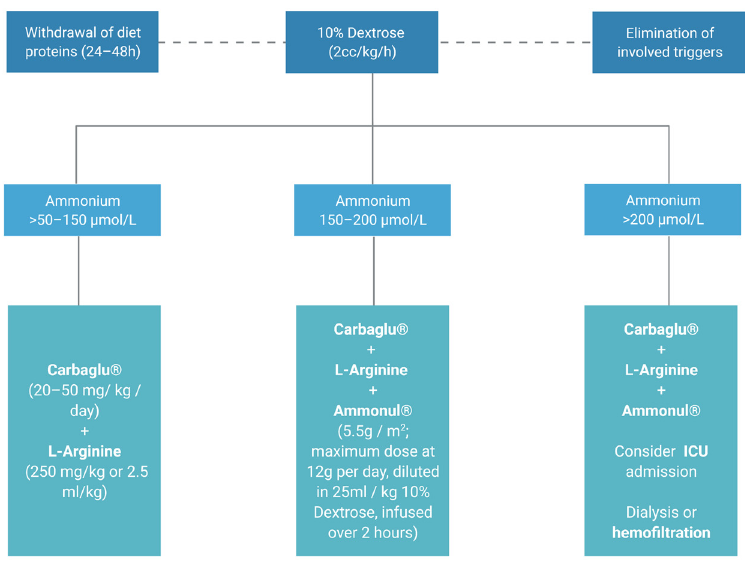
Figure 4. Recommendation of an hyperammonemia approach in the emergency department.